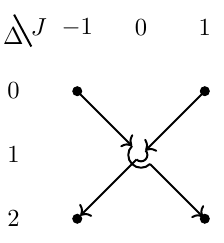
Figure 4 . Celestial ‘Diamonds’ for the Subleading Soft